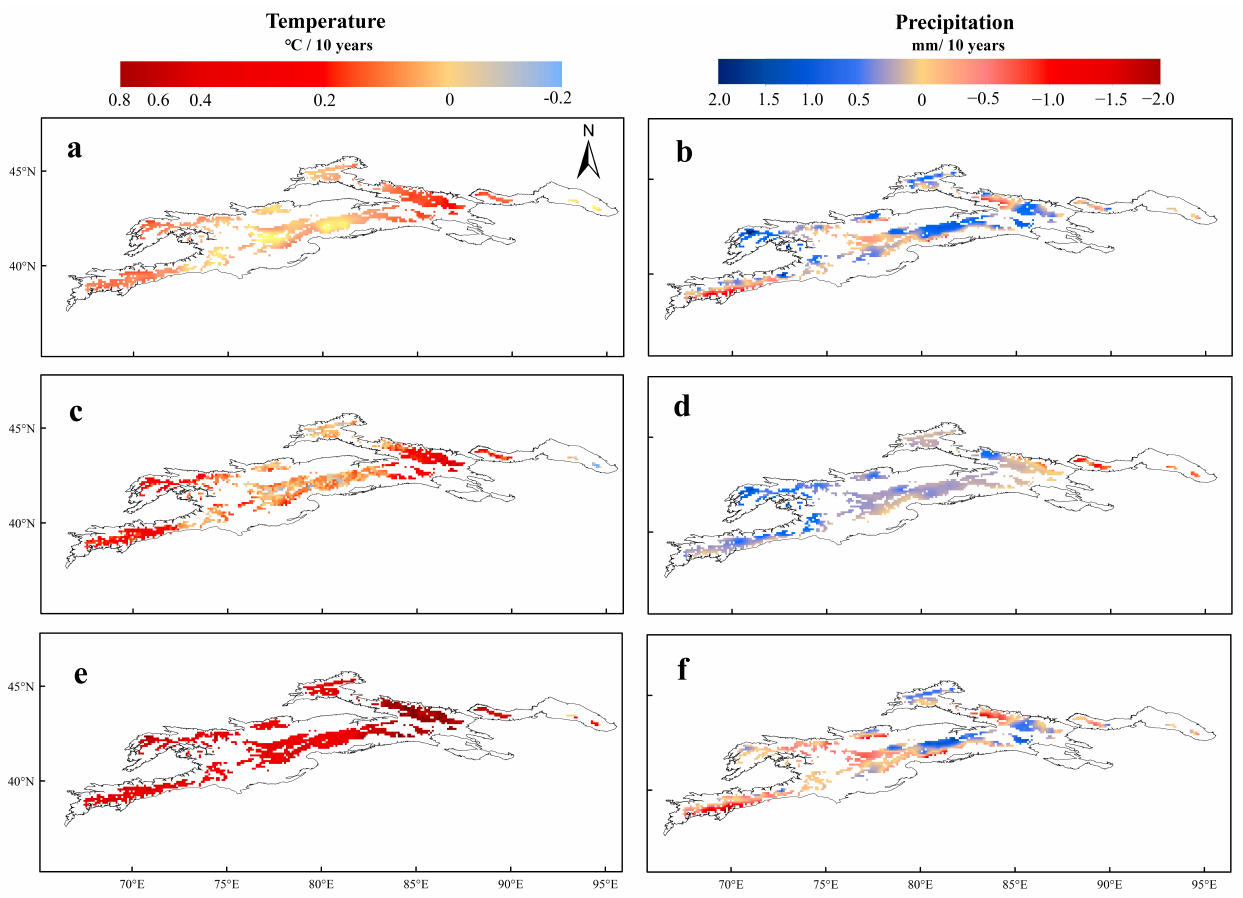
Figure 4. Variations in the linear trend of temperature and precipitation for annual average ( a , b ), the accumulation period from October to March ( c , d ), and the ablation period from April to September ( e , f ) in the Tien Shan